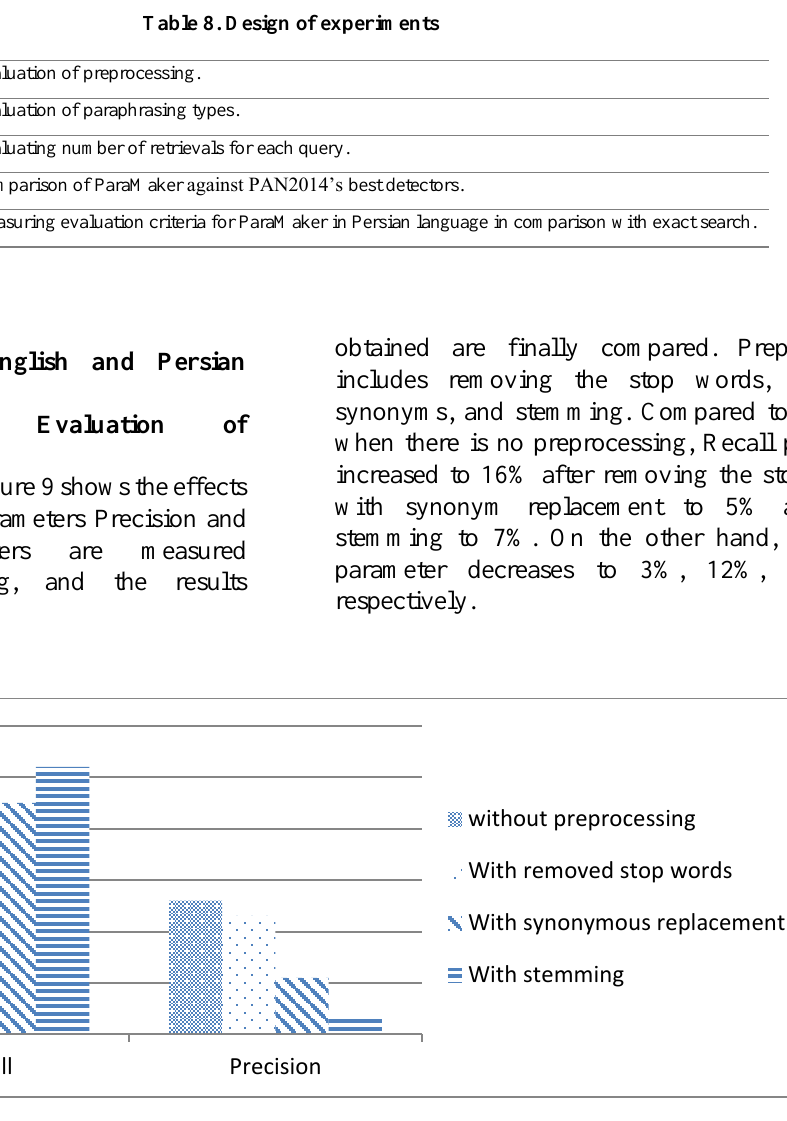
Figure 9. Evaluations of